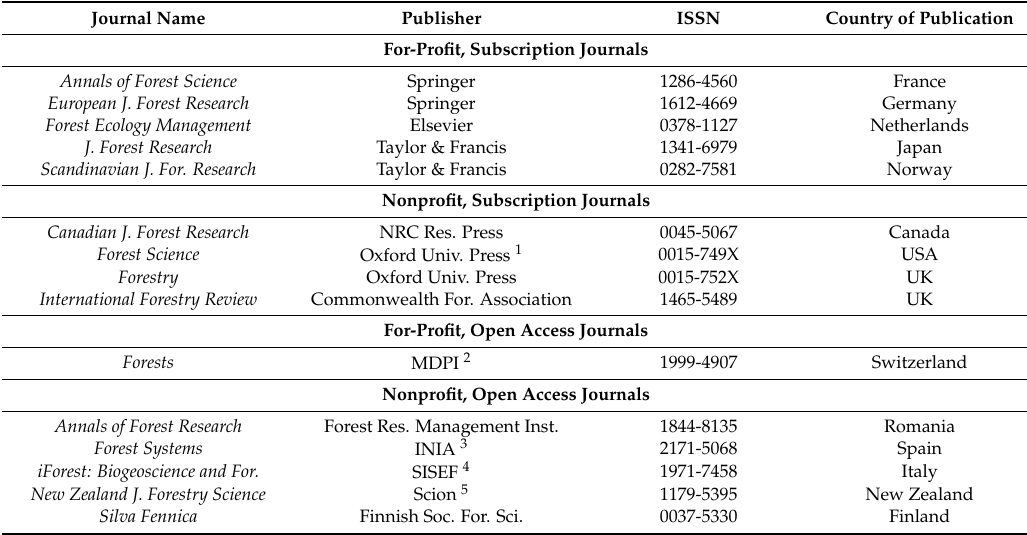
Table 1. Journals included in this analysis—in alphabetical order within category—including ISSN and country of